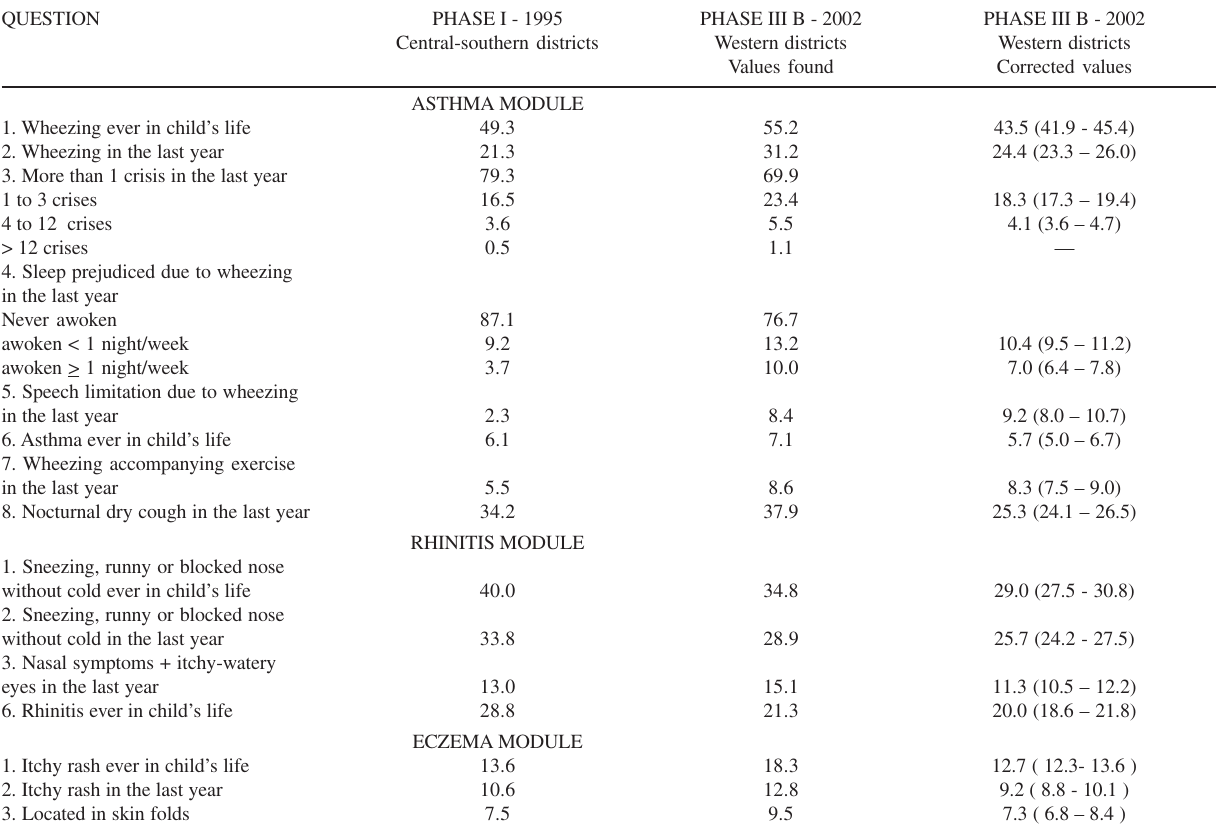
Table 5. Comparison of the asthma , rhinits and eczema (%) symptom prevalences between Phases I and III B of the ISAAC project, with and without correction, in São Paulo City in 1995 and 2002